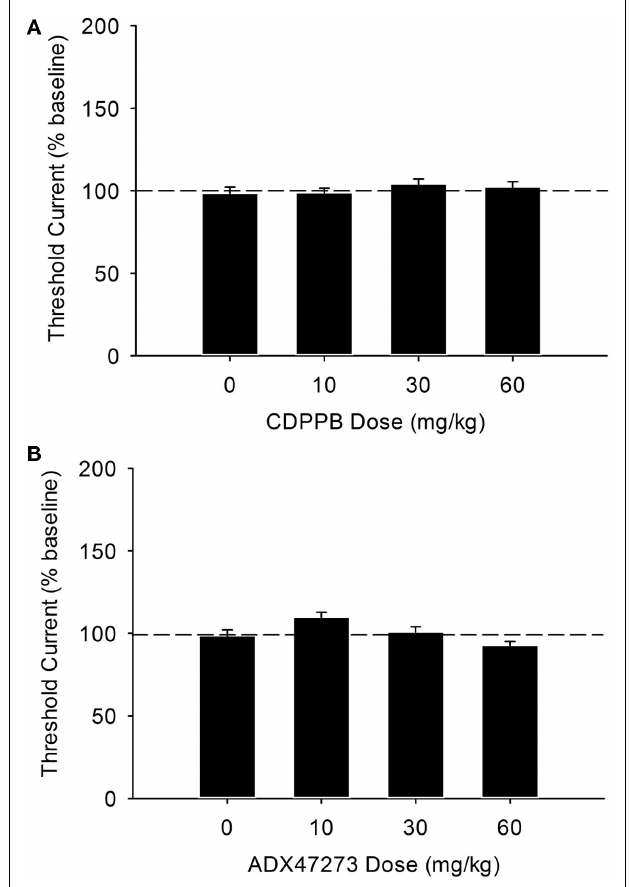
FIGURE 1 | Dose-dependent increases in ICSS thresholds following acute administration of the mGlu5 NAMs MTEP [(A): n = 13] or fenobam [(B): n = 11]. * P < 0.05 vs. vehicle.